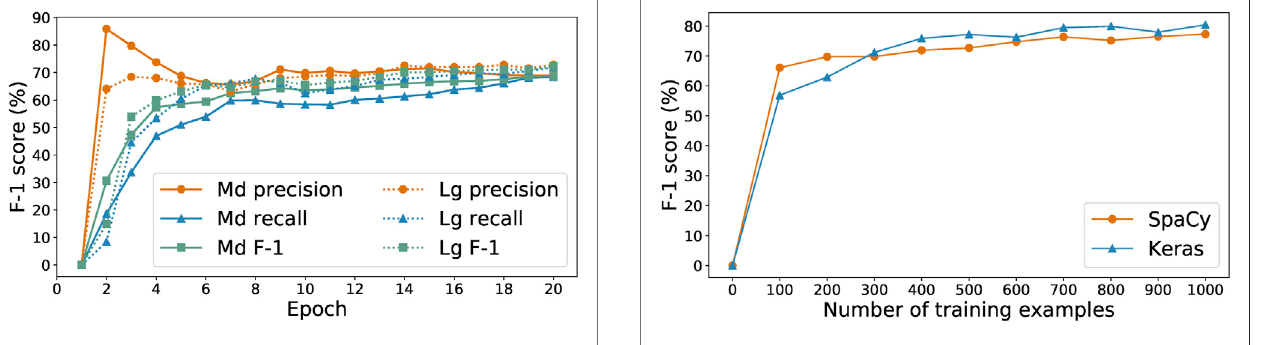
FIGURE3| TrainingcurvesfortheSpaCyandKerasmodelsfordifferent number of examples